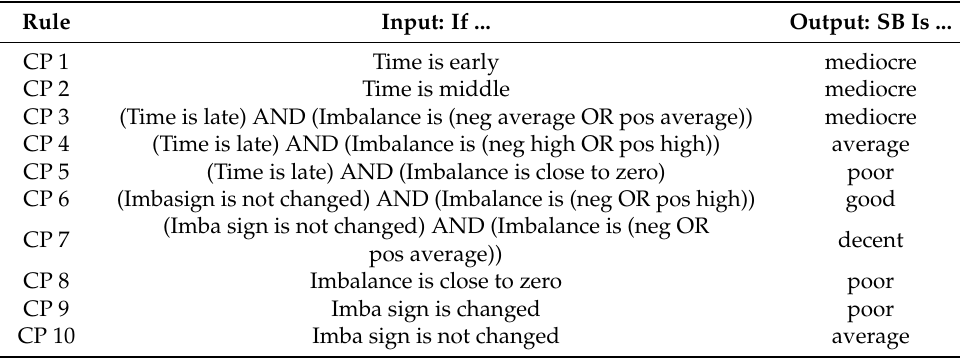
Table A4 shows fuzzy logic rules with the Dutch approach of combined pricing. Imbalance means the ACE in the current time step. This value represents the risk of changing to dual pricing in the combined pricing approach. Table A4. Overview of fuzzy logic rule set for combined pricing (NL). Rule Input: If ... Output: SB Is ...